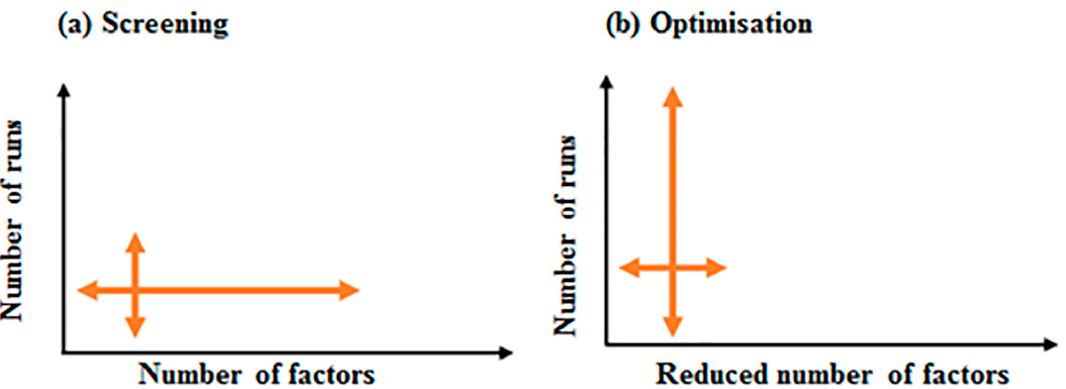
Figure 4. A comparative illustration of screening and optimisation designs. ( a ) In screening designs a large number of factors, with reduced number of runs, are used to screen for important factors affecting the process. ( b ) In optimisation designs, a reduced number of factors, with large number of runs, are utilised to find the optimum conditions for high yield of recombinant protein.